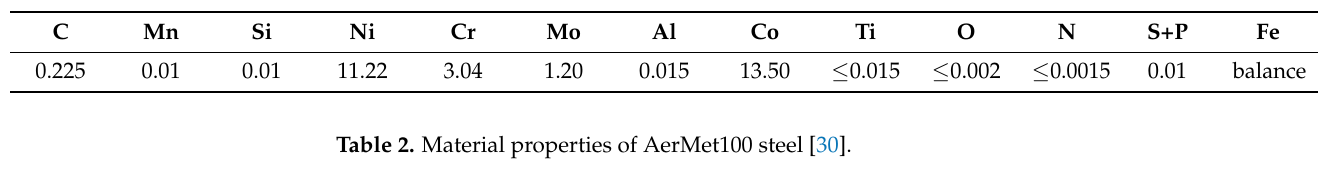
Table 1. Chemical compositions of AerMet100 steel [29].